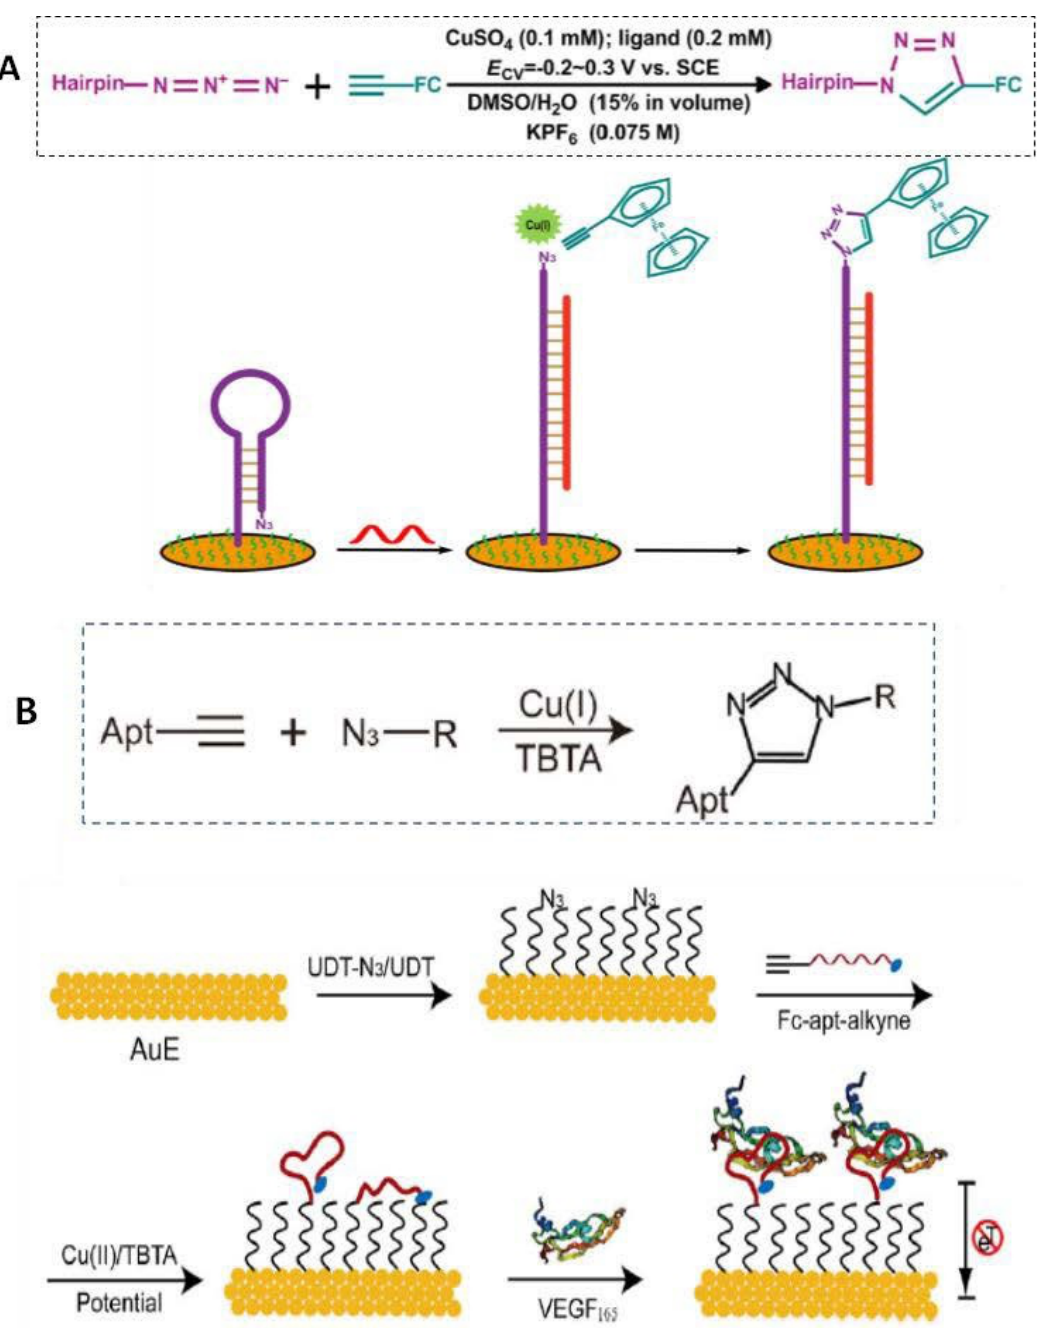
Figure 7. Schematic illustration of electrochemical DNA biosensors prepared onto gold electrodes by direct immobilization of dually thiol- and azide-labeled probes, followed by hybridization and electroclick reaction (inset) with ethynilferrocene ( A ). Fabrication of a mixed monolayer of 11-azido-1-undecanethiol (N 3 UDT) and UDT, followed by electroclick (inset) with Fc and the alkyne-modified probe, and target binding ( B ). Reprinted from [65] ( A ) and [73] ( B ) with permission.